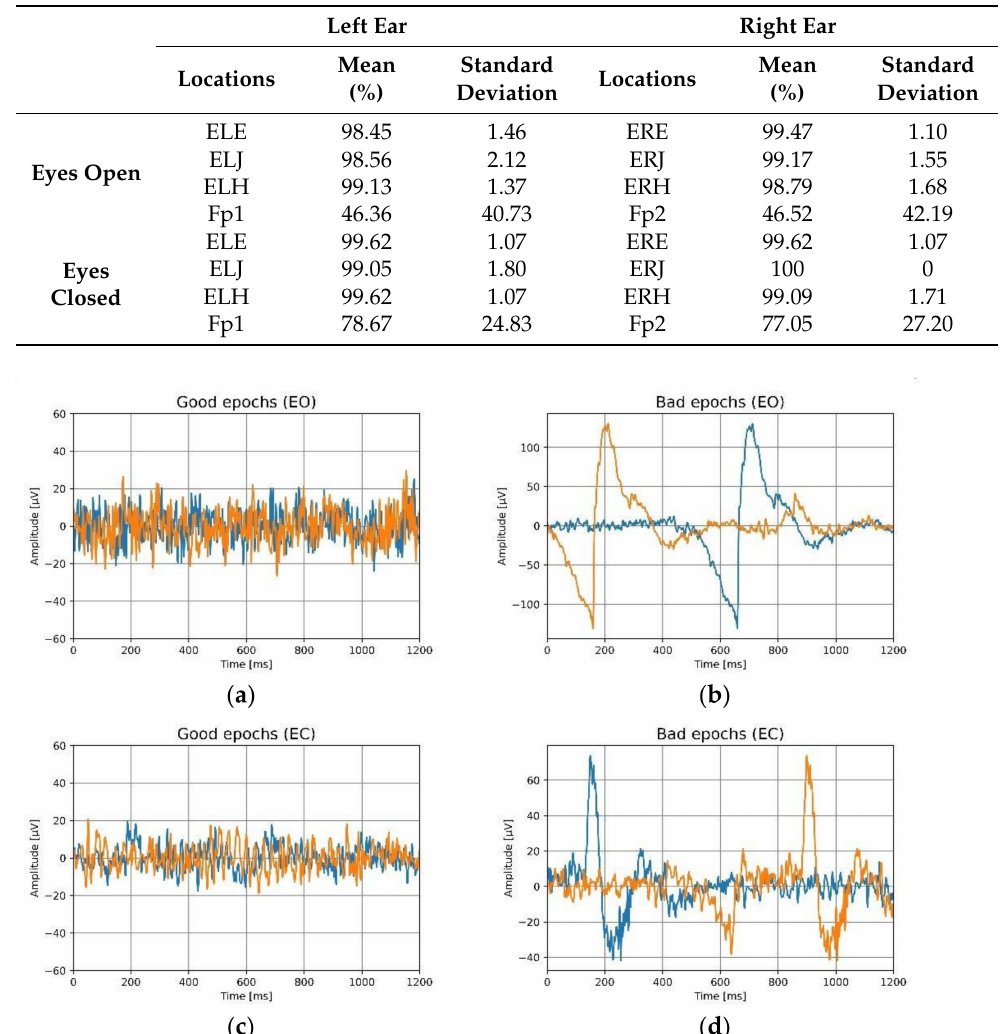
Table 5. Amount of good data for left and right ear in eyes-open and eyes-closed conditions.